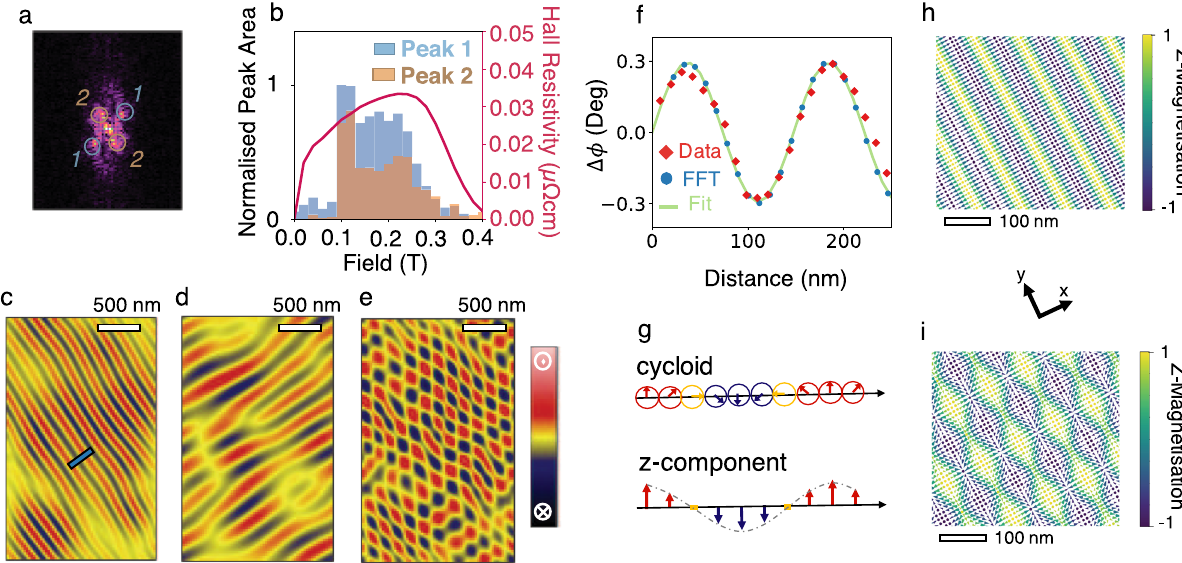
Fig. 3 Fourier analysis of MFM images. a Typical Fourier transform (here from 0.22 T), indicating the satellite peaks present during the periodic magnetic phase, with pairs of peaks labelled. b Normalised integration of the Fourier peak areas for the satellite peaks, plotted at each fi eld, with the modulus of the Hall resistivity plotted for direct comparison. c , d MFM signals extracted by isolating the relevant respective peaks from the Fourier transform acquired from the 0.22 T scan. Line scan marked with a blue bar in c is plotted in f . e MFM signals extracted by isolating signals responsible for both peaks (convolution of c and d ), resulting rectangular lattice is rotated ~28° to the scan direction. f Line scans extracted from raw data in Fig. 2b, and FFT extracted data in c fi tted with a sine curve. g Schematic of a cycloidal phase, and how the z component of such a phase appears to vary. h 3D magnetisation simulation of a cycloidal phase with a single propagation vector. i 3D magnetisation simulation of an anisotropic incommensurate (IC) spin crystal, a cycloidal phase with two in plane perpendicular propagation